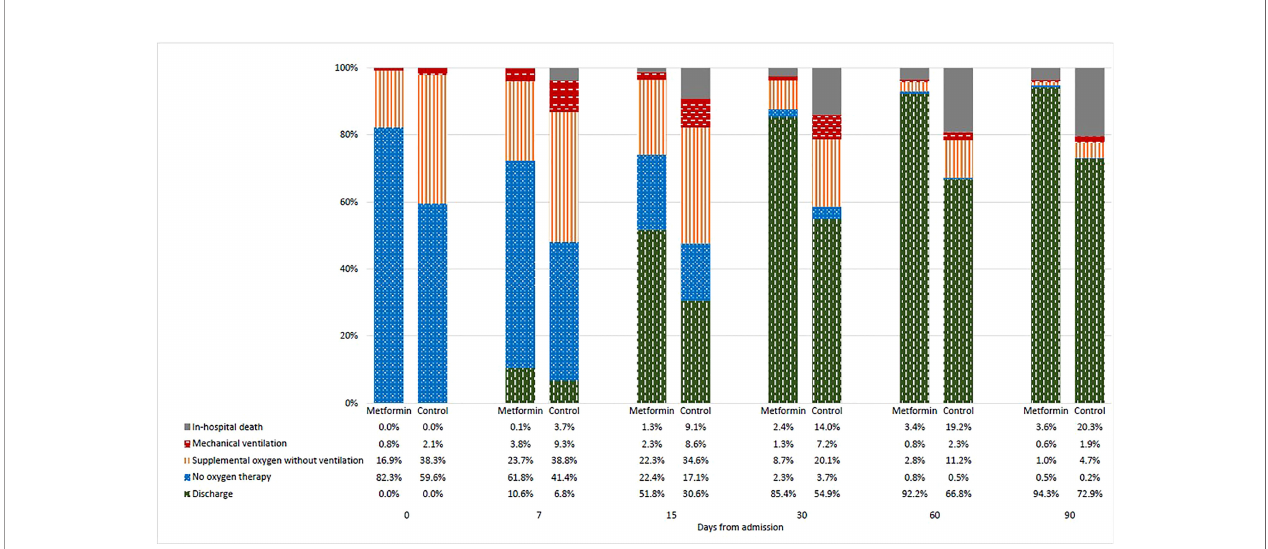
FIGURE 1 | Changes in clinical status of patients as indicated by the WHO Clinical Progression Scale score from baseline to day-90 by treatment